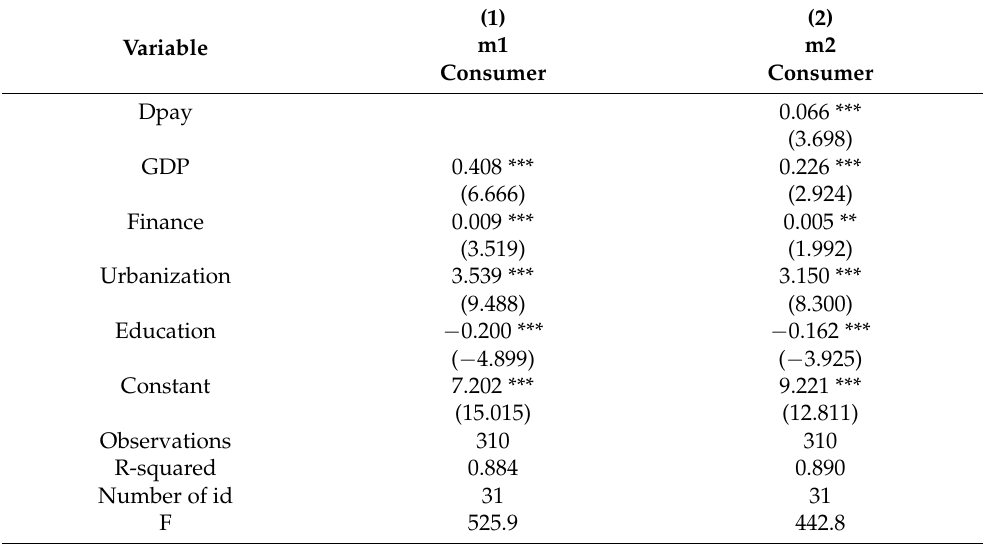
Table 4. Benchmark regression